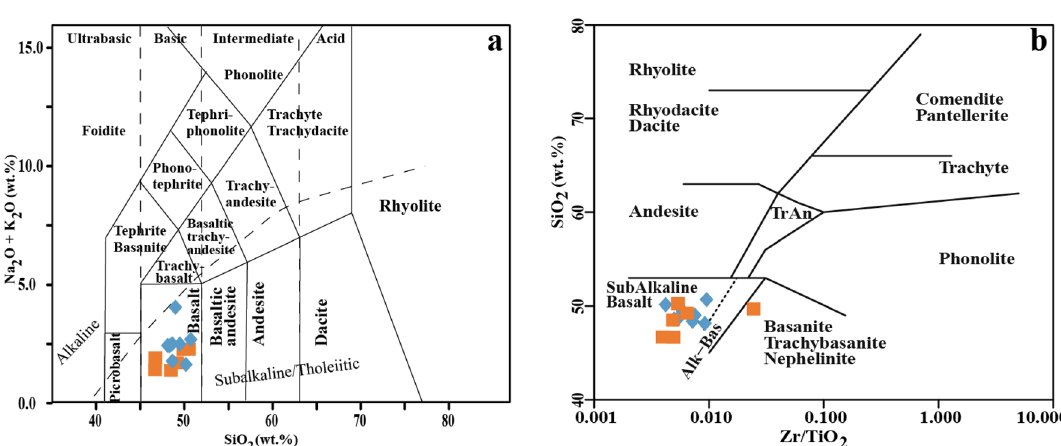
Fig. 7 a Total alkali-Silica (TAS) diagram after [71] of the studied rocks and b Binary diagram from [70]) showing the FGM and the CGM plot- ting in sub-alkaline basalts field. Symbols are the same as in Fig.